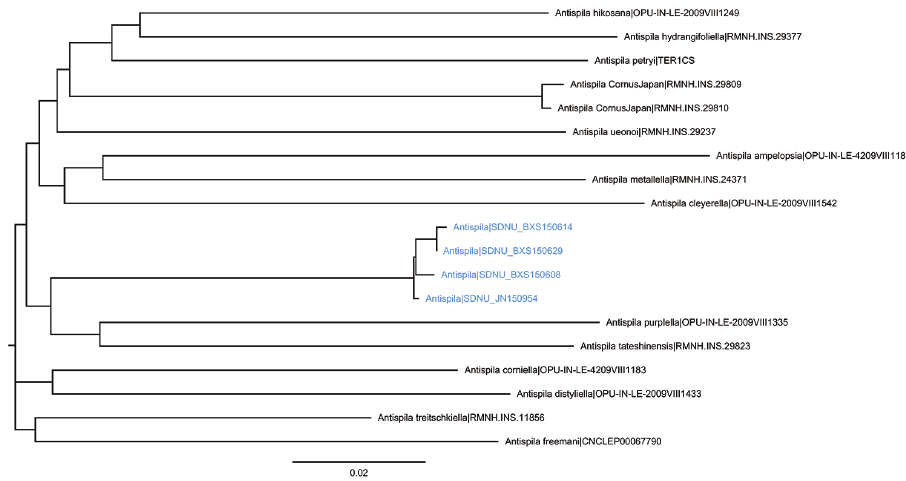
Figure 23. Neighbor-joining tree estimated from DNA barcode sequences under dataset “DS-ANTISIN”, performed by using Kimura 2-Parameter model. Clades representing A. sinensis sp. n. are marked